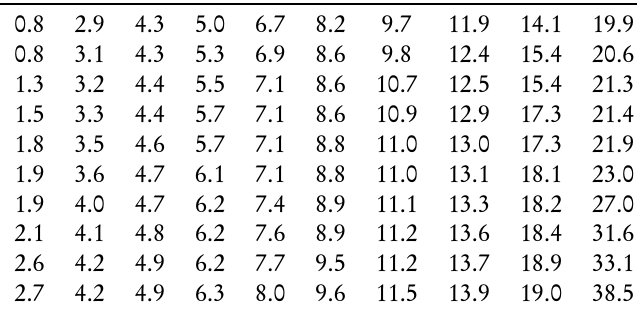
Data of waiting times of 100 bank